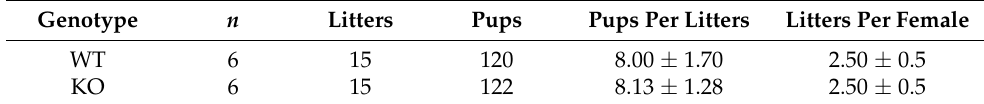
Table 1. Fertility assessment in female mice with targeted deletion of Clpp in granulosa cells. Genotype n Litters Pups Pups Per Litters Litters Per Female WT 6 15 120 8.00 ± 1.70 2.50 ± 0.5 KO 6 15 122 8.13 ± 1.28 2.50 ± 0.5 Fertility of female Clpp − / − and WT mice (8-week-old, n = 4 for each genotype) was assessed by mating with WT males of proven fertility (male/female; 1:1) for 12 weeks. Clpp − / − mice had a similar litter size (pups per litter) and litters per female compared with WT